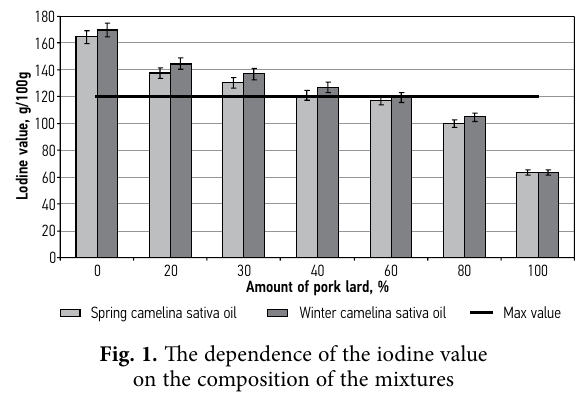
Spring camelina sativa Fig. 1 . The dependence of the iodine value on the composition of the mixtures of Camelina sativa oil and pork lard